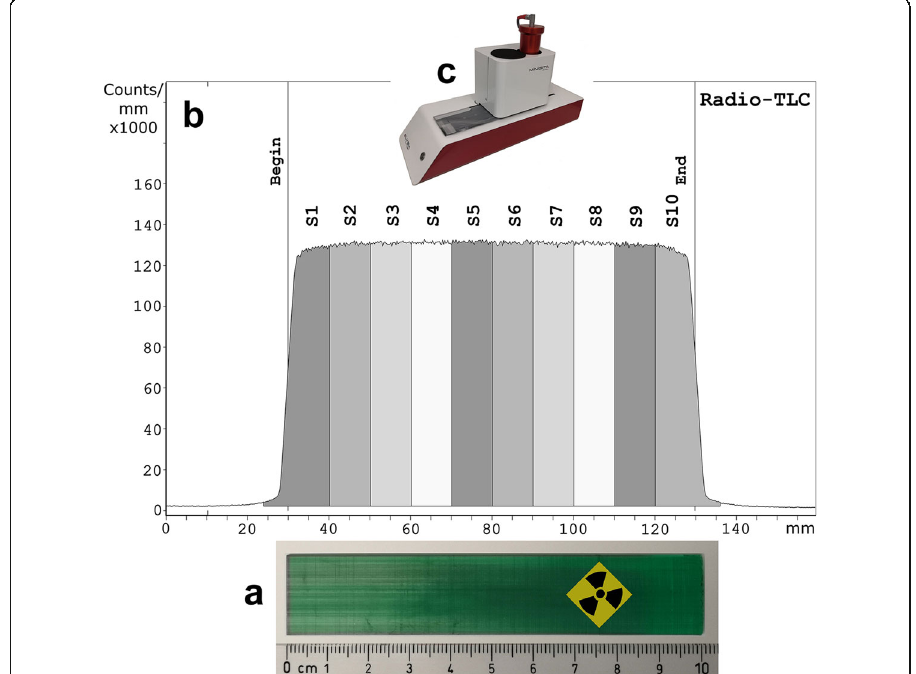
Fig. 2 Photo of the green bar-shaped phantom ( a ) and radioactivity distribution along the phantom ( b ) as determined on a radio-TLC system ( c ). Integration of radioactivity counts for each of the ten 1-cm-sections (S1 – S10) on the TLC system resulted in almost identical values (~ 1.3 × 10 6 counts) with a relative standard deviation (RSD) of